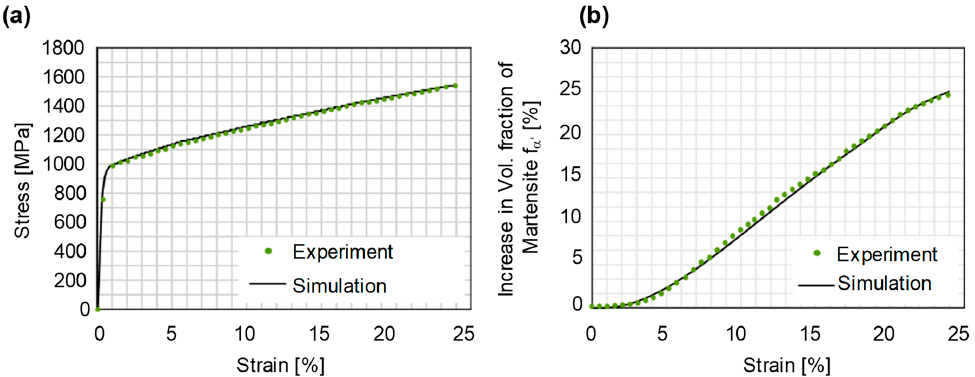
Figure 8. Comparison of experimental and optimized numerical curves: ( a ) Stress-strain, ( b ) evolution of the martensite content as a function of the plastic strain.